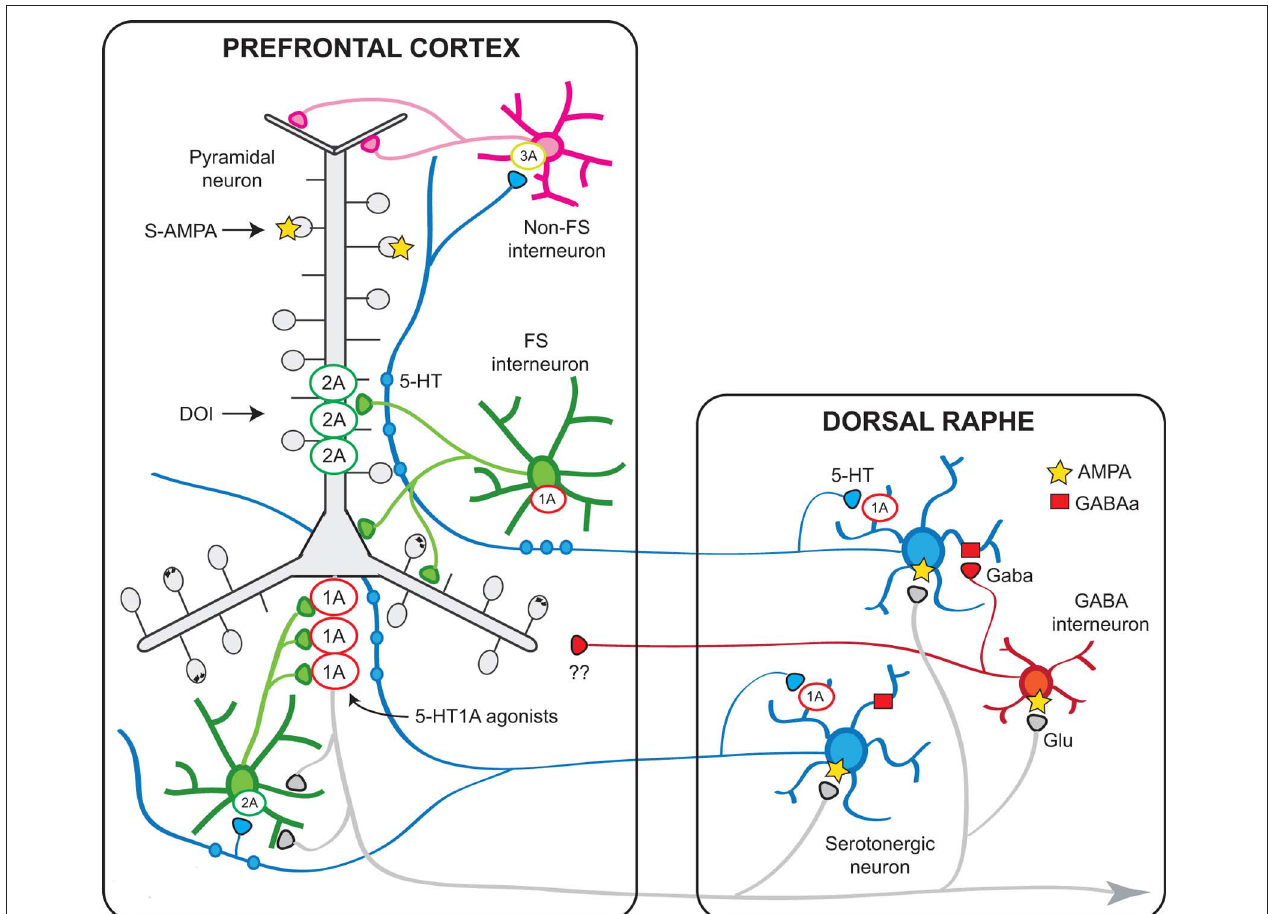
FIGURE 9 | Schematic representation of the relationships between the mPFC and the DR involving 5-HT 1A and 5-HT 2A receptors. Pyramidal neurons in the mPFC project densely to the DR/MnR and modulate the activity of serotonergic neurons via direct and indirect influences (Celada et al., 2001). In turn, endogenous 5-HT modulates pyramidal cell activity through the activation of various receptors expressed in the neocortex, of which 5-HT 1A and 5-HT 2A receptors play a major role. The latter receptors are particularly enriched in apical dendrites of pyramidal neurons where they can facilitate AMPA inputs. A smaller population of 5-HT 2A receptors are expressed by GABA interneurons, including fast-spiking (FS) interneurons. Pyramidal 5-HT 1A receptors may be localized in the axon hillock, together with GABAA receptors activated by chandelier axons (Azmitia et al., 1996; De Felipe et al., 2001; Cruz et al., 2004) or in the somatodendritic compartment (Riad et al., 2000). It is possible that 5-HT